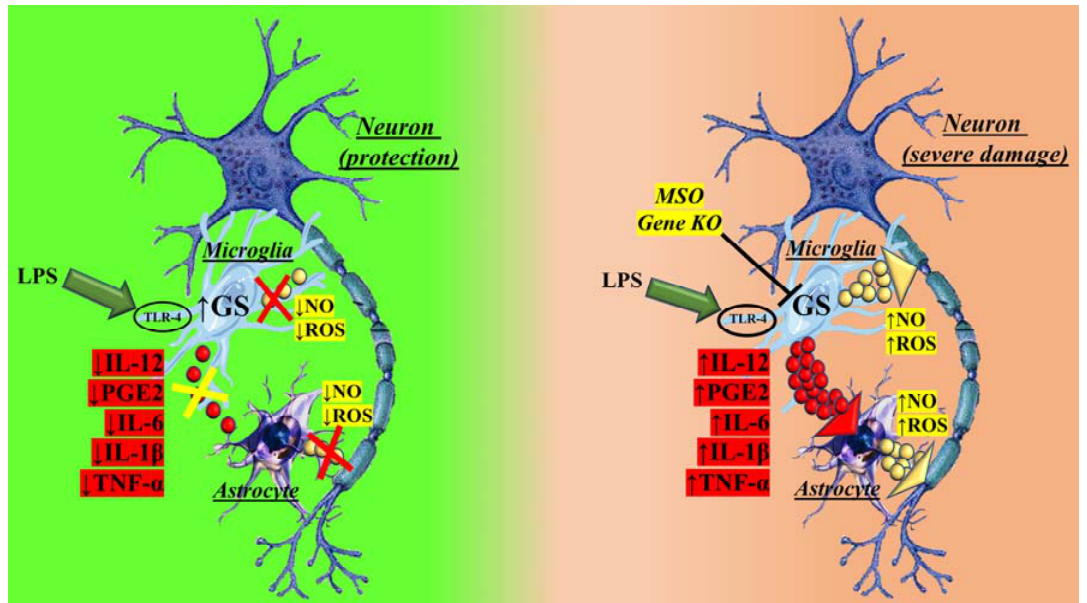
Figure 1. Role of glutamine synthetase (GS) in brain physiology. Brain relies on the reaction catalyzed by GS, which is known to take place mainly in astrocytes, as a fundamental mechanism for ammonia and glutamate removal. Microglia also express GS and participate with astrocytes in this task. Microglia possess an endogenous mechanism modulating their response to a proinflammatory agent, such as lipopolysaccharides (LPSs). By expressing GS microglial response to LPS is controlled, limiting thus the consequent harmful effects on surrounding cells (left). When this mechanism is lost (GS blockade, oxidation-related GS loss of function, GS inhibition with methionine sulfoximine, MSO) microglia engage a strong inflammatory response to LPS, producing inflammatory mediators and effectors, and leading to neuronal damage. ROS: reactive oxygen species; KO: knock-out; IL-12: